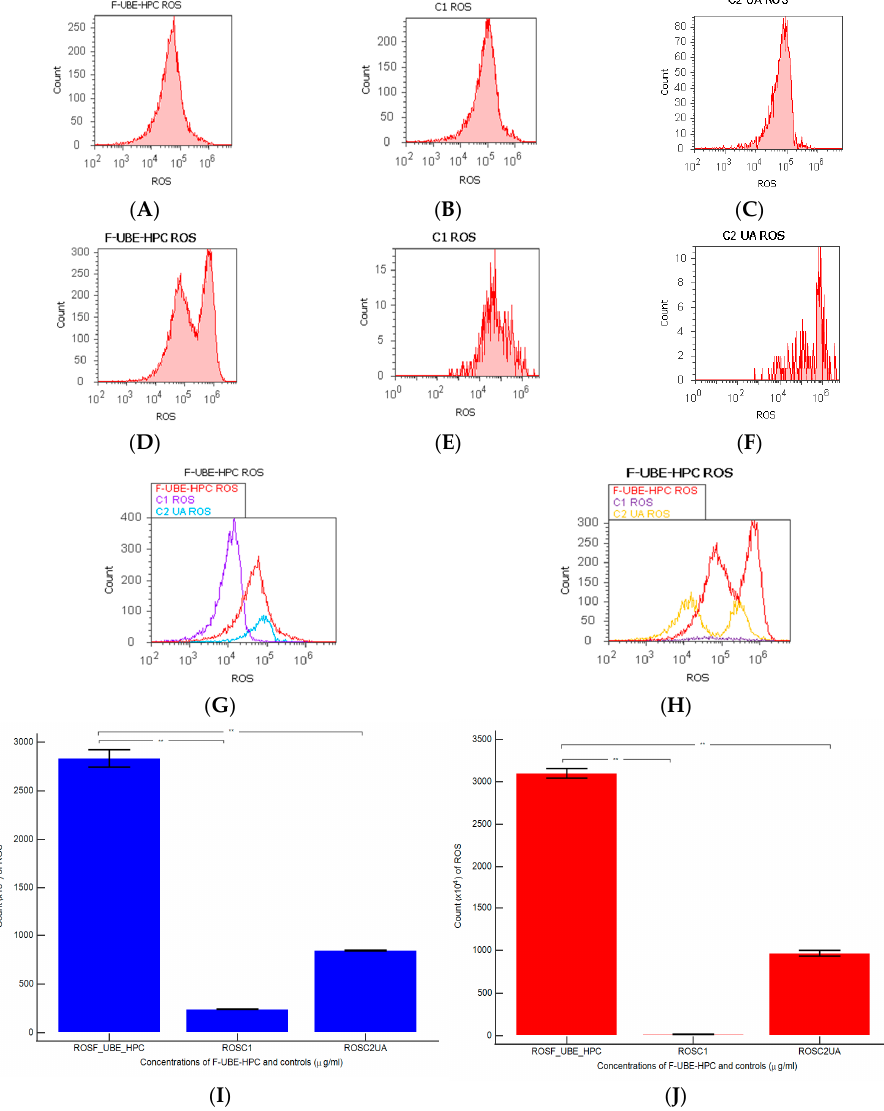
Figure 11. Reactive oxygen species (ROS) after 24 h treatment with F-UBE-HPC applied to normal blood cells ( A – C ) and CLS-354 tumor cells ( D – F ); 1% DMSO negative control ( B , E ); 125 µ g/mL UA positive control ( C , F ); F-UBE-HPC and controls extrapolated on ROS axis ( G , H ); statistical analysis of ROS ( I , J ) in normal blood cell cultures ( I ); CLS-354 tumor cell line ( J ). ** p < 0.01 represents significant statistical differences between controls and samples made by paired samples t -test; C1—negative control with 1% dimethyl sulfoxide (DMSO); C2UA—positive control with 125 µ g/mL usnic acid (UA); F-UBE-HPC—bioadhesive oral film loaded with U. barbata dry ethanol extract. ROS levels substantially increased in the blood cells treated with F-UBE-HPC compared with the 1% DMSO negative control and positive control of 125 µ g/mL of UA (2833.33 × 104 ± 152.75; vs. 242.00 × 104 ± 2.00; 846.66 × 104 ± 5.77; p < 0.01, Figure 11A–C,G,I). Oxidative stress was strongly augmented in the OSCC cell line after 24 h contact with F-UBE-HPC compared with the 1% DMSO negative control and 125 µ g/mL of UA